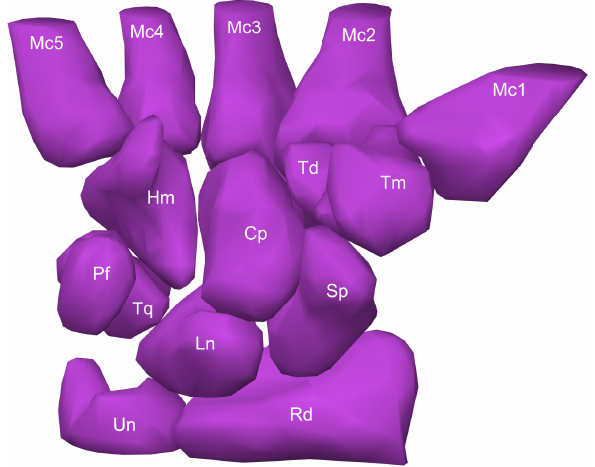
Figure 4. Carpal bone anatomy of a healthy male from a palmar view. The carpus consists of eight carpal bones which are arranged in proximal and distal rows. The proximal row contains the scaphoid (Sp), lunate (Ln), triquetrum (Tq), and pisiform (Pf), while the distal row contains the trapezium (Tm), trapezoid (Td), capitate (Cp), and hamate (Hm). The distal row adjoins the five metacarpals (Mc1-5) of the wrist. The radius (Rd) and ulna (Un) are also